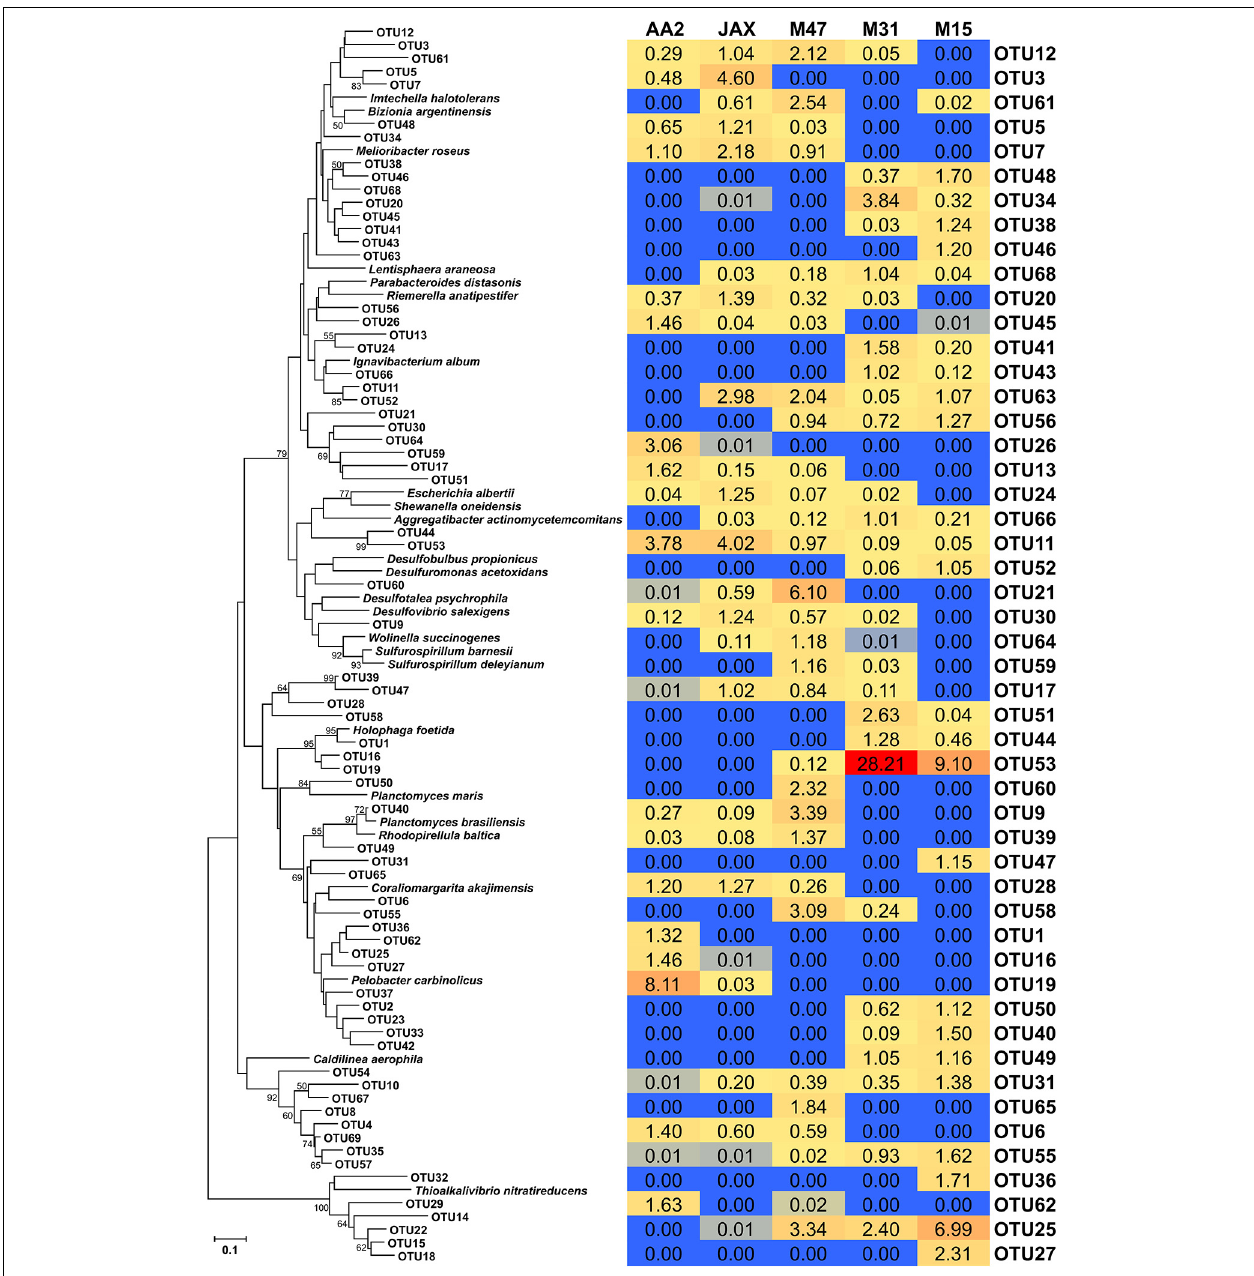
FIGURE 3 | Phylogenetic tree and heat map of dominant NrfA OTUs in the New River Estuary. Dominant OTUs were defined as the OTUs containing more than 1% of total number of NrfA sequences in each community. Neighbor-joining tree was constructed from amino acid